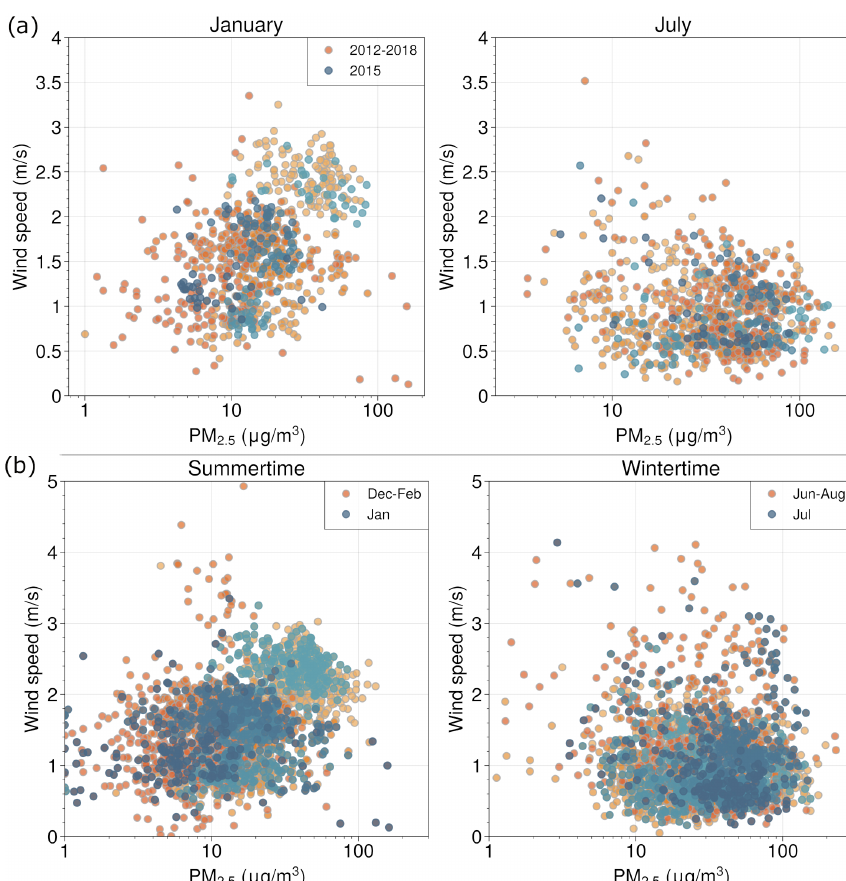
Figure 11. (a) Relevance of the year 2015 for wind speed and PM 2 . 5 in January (left) and July (right). Daily mean from hourly data from the SINCA network, for five stations throughout central Chile (Andacollo, Viña del Mar, Parque O’Higgins, Rancagua and Talca – see Table 2 for their location). Each color shade corresponds to a different station. Data from 2015 (blue) is compared to data for the period 2012–2018 (orange) excluding 2015. (b) Relevance of January and July as representative of summertime and wintertime. Same data as (a) , but orange is now DJF (left) and JJA (right) and blue is January (left) and July